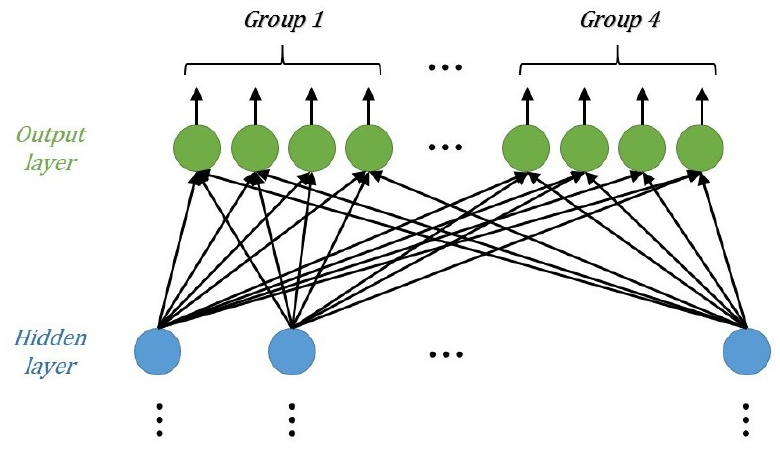
Figure 8. Design of the output